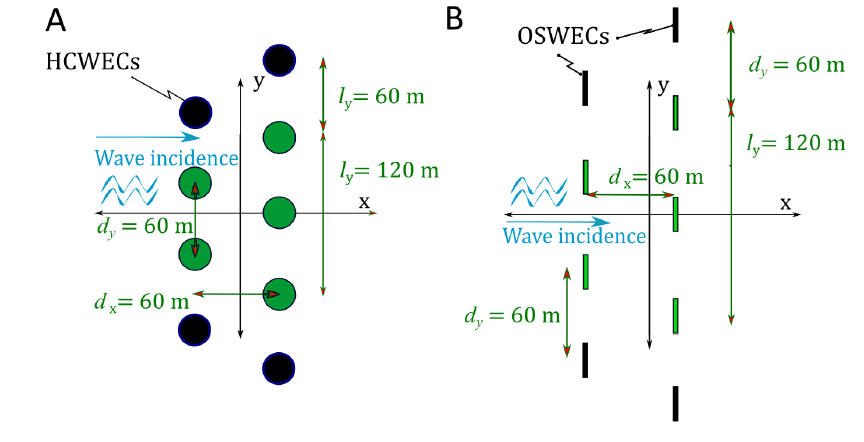
Figure 4. Plane (top) view of all different WEC array layouts used in the numerical simulations. ( A